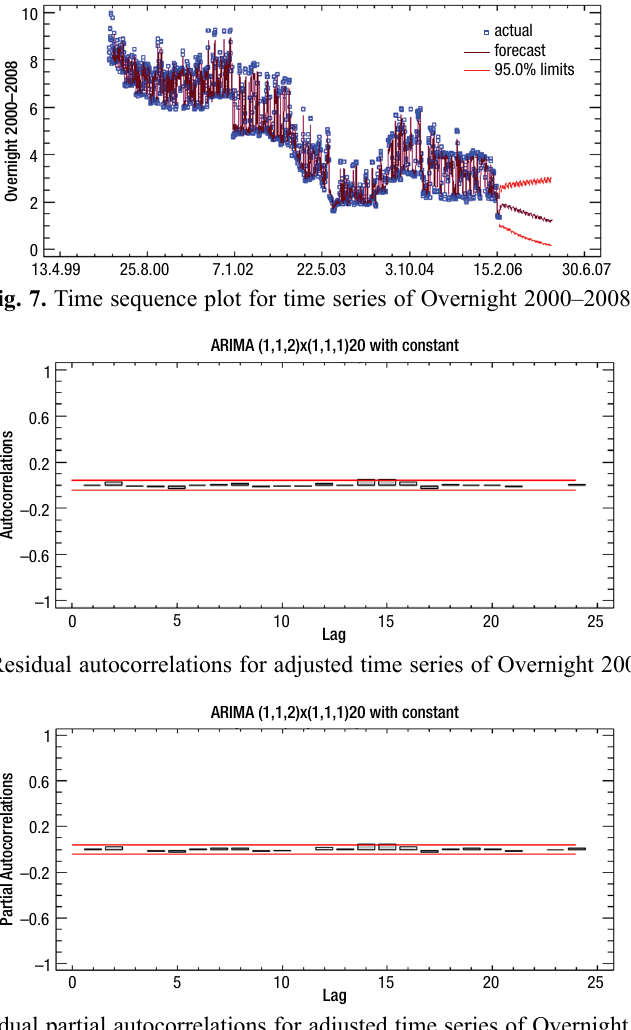
Fig. 8b. Residual partial autocorrelations for adjusted time series of Overnight 2000–2008